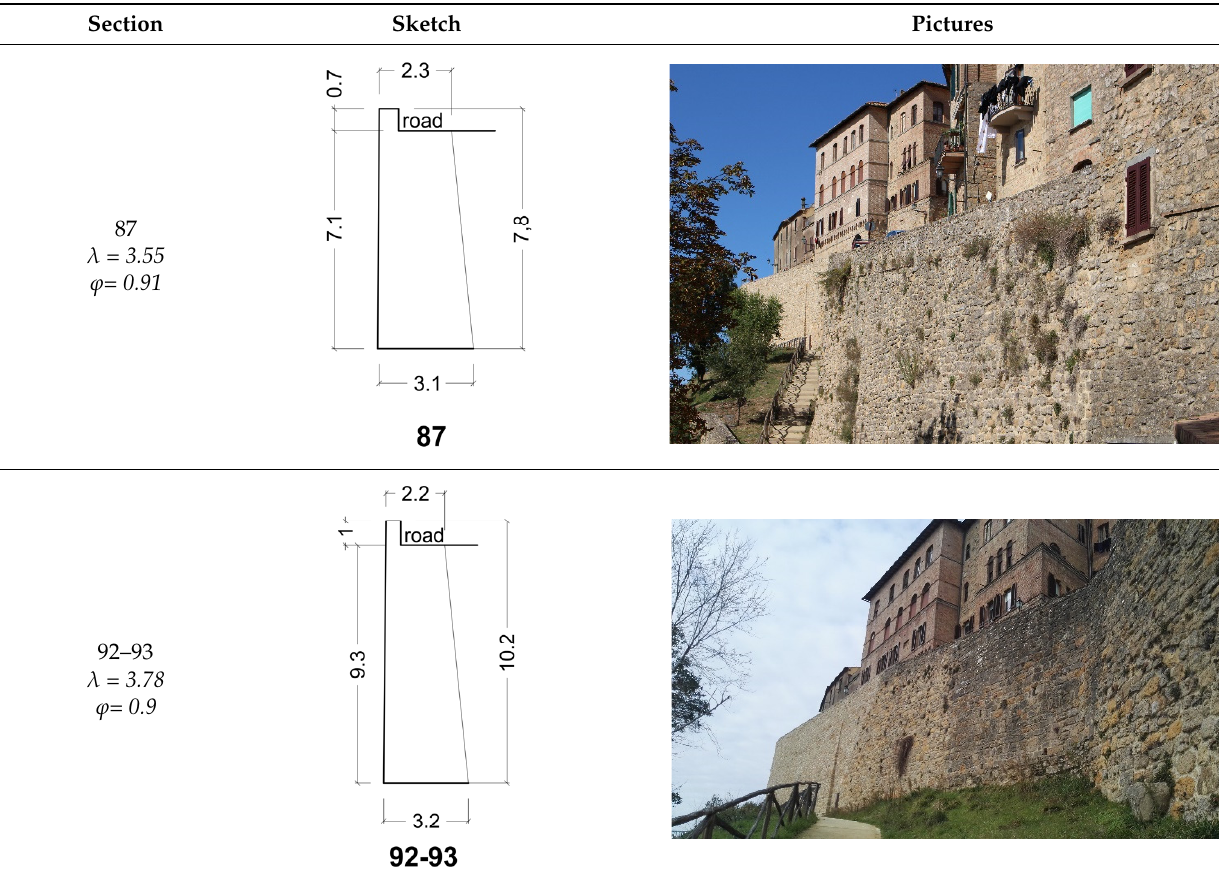
Figure 3. Typical drawing of a HUW. Relative displacements ( a ) and verification sections ( b ).